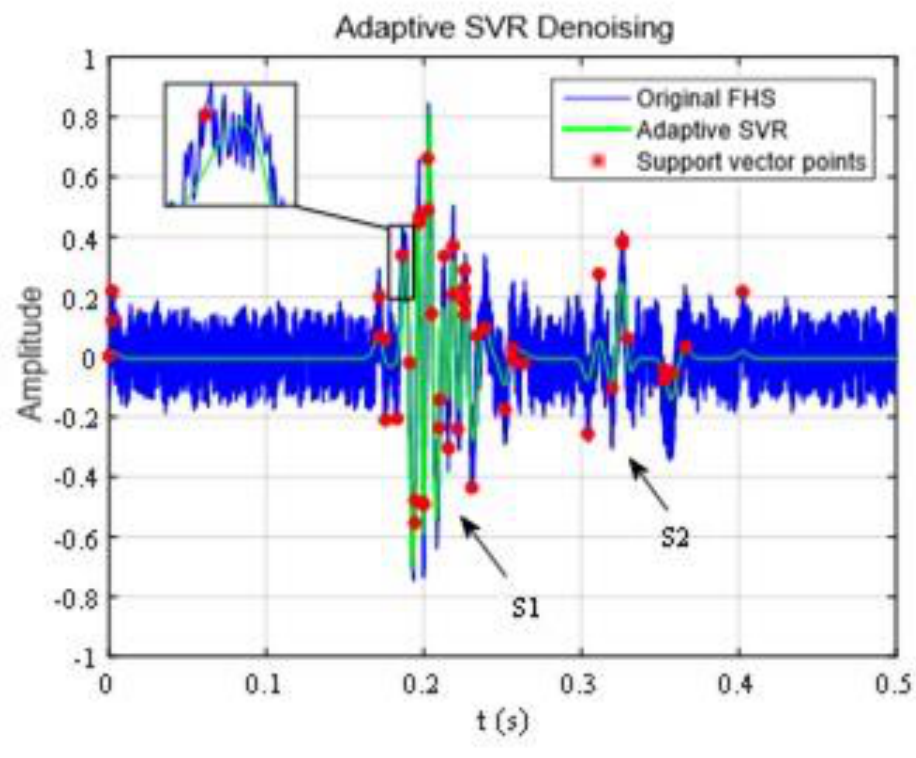
Figure 5. Adaptive Support Vector Regress (SVR) noise reduction of fetal heart sound. The noise in the original fetal heart sound data is larger and the second heart sound is almost completely covered. The adaptive SVR algorithm followed well in the first and second heart sounds and inhibited the noise effectively in the other part. The tendency of the fitting curve was severely restricted by the points of the